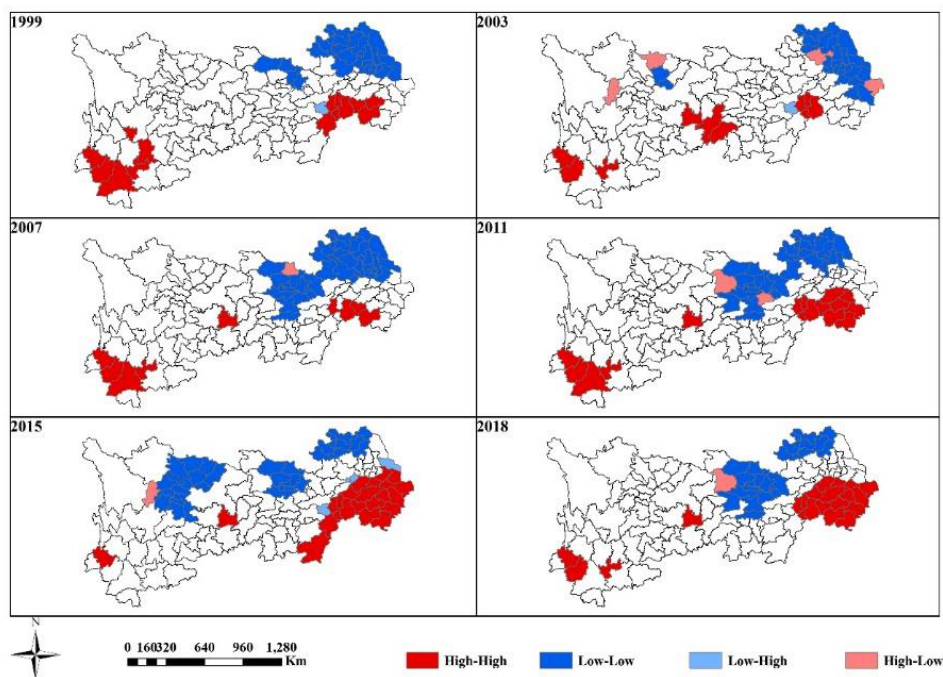
Figure 10. The spatial heterogeneity of the coupling system in 110 cities from 1999 to 2018.